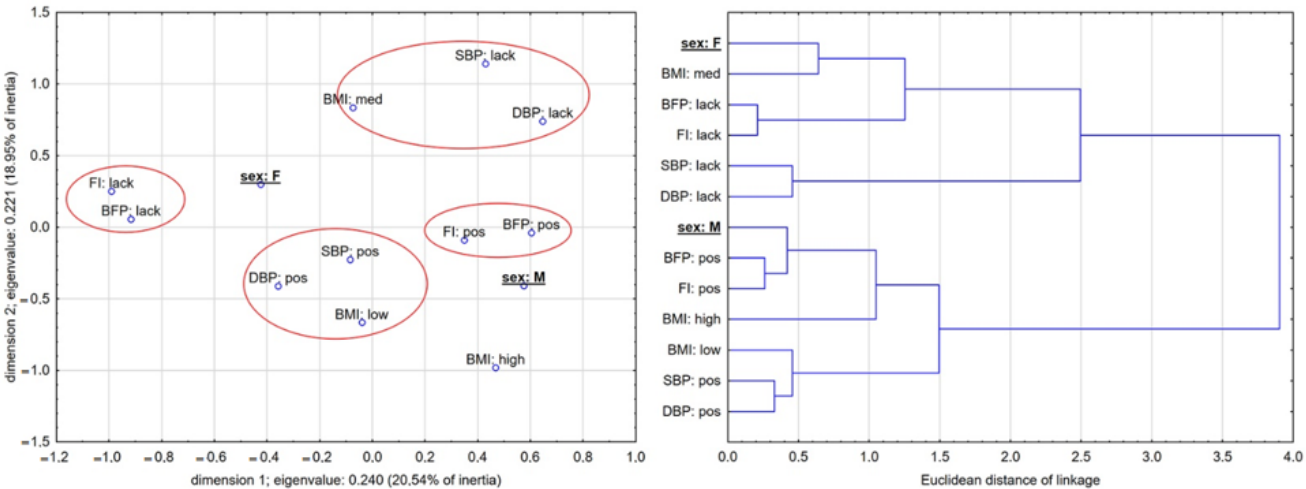
Figure 1. Results of intervention effects on the co-occurrence of changes in independent variables concerning sex and BMI status . Taxonomical dendrogram illustrates similarities and distances (strength) of linkages.